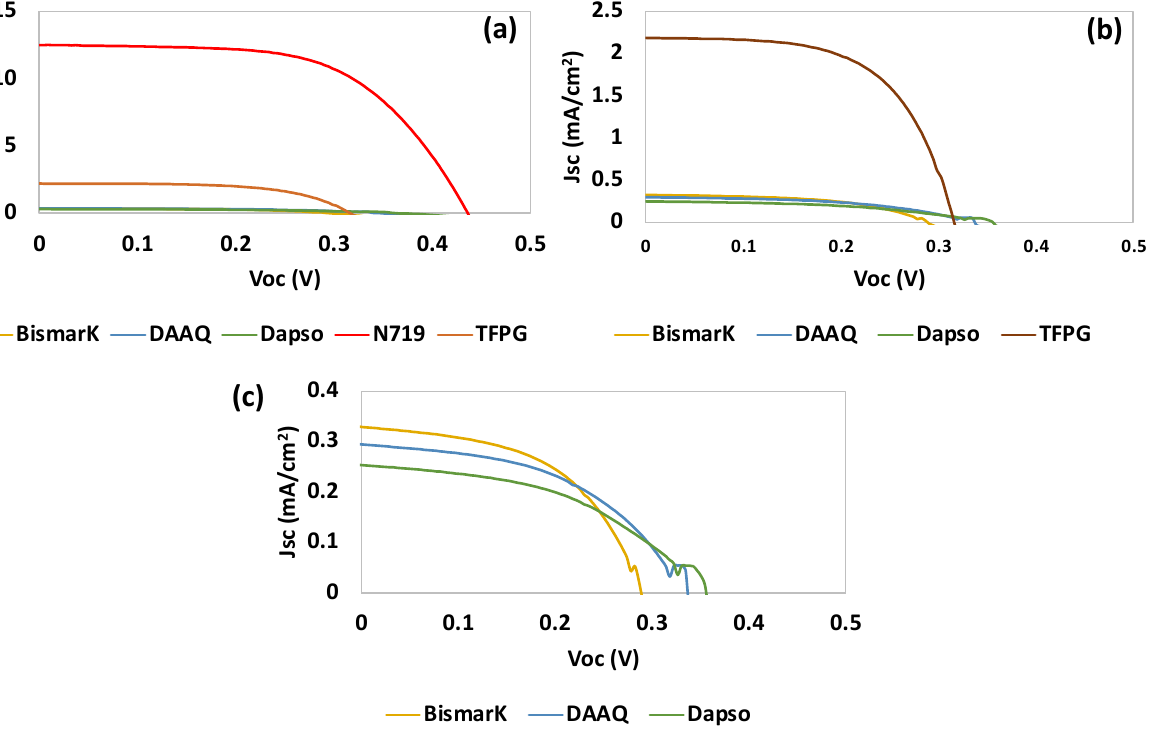
Table 2. Photovoltaic performance parameters of DSSCs based on COFs RIO-60 as a dye replace- ment. The initial assessment was conducted under simulated AM 1.5 G illumination at 100 mW/cm 2 . ( The presented results correspond to the best-performing cell ).